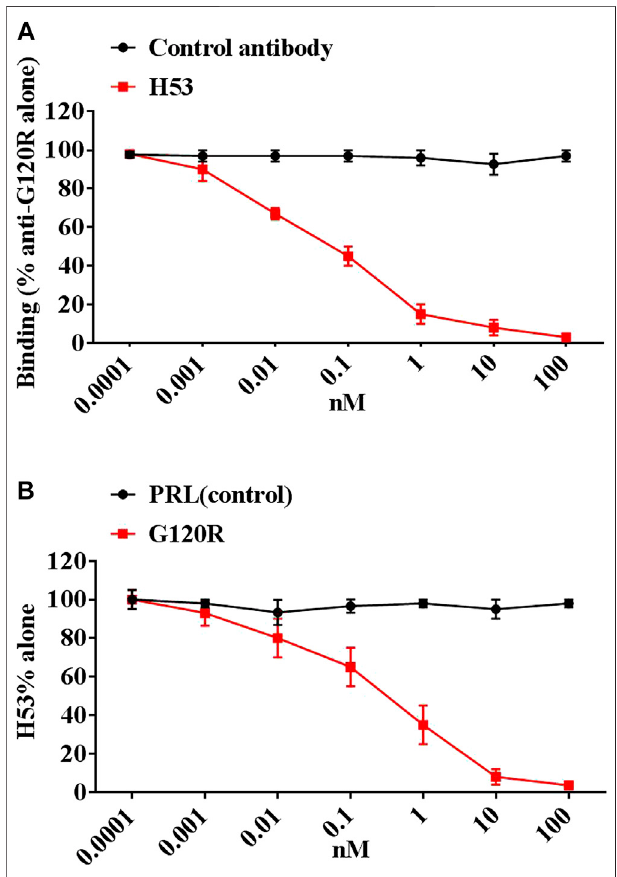
FIGURE2|(A) H53inhibitedtheanti-G120RbybindingtoGHinadose- dependent manner. The ELISA plates were coated with G120R as